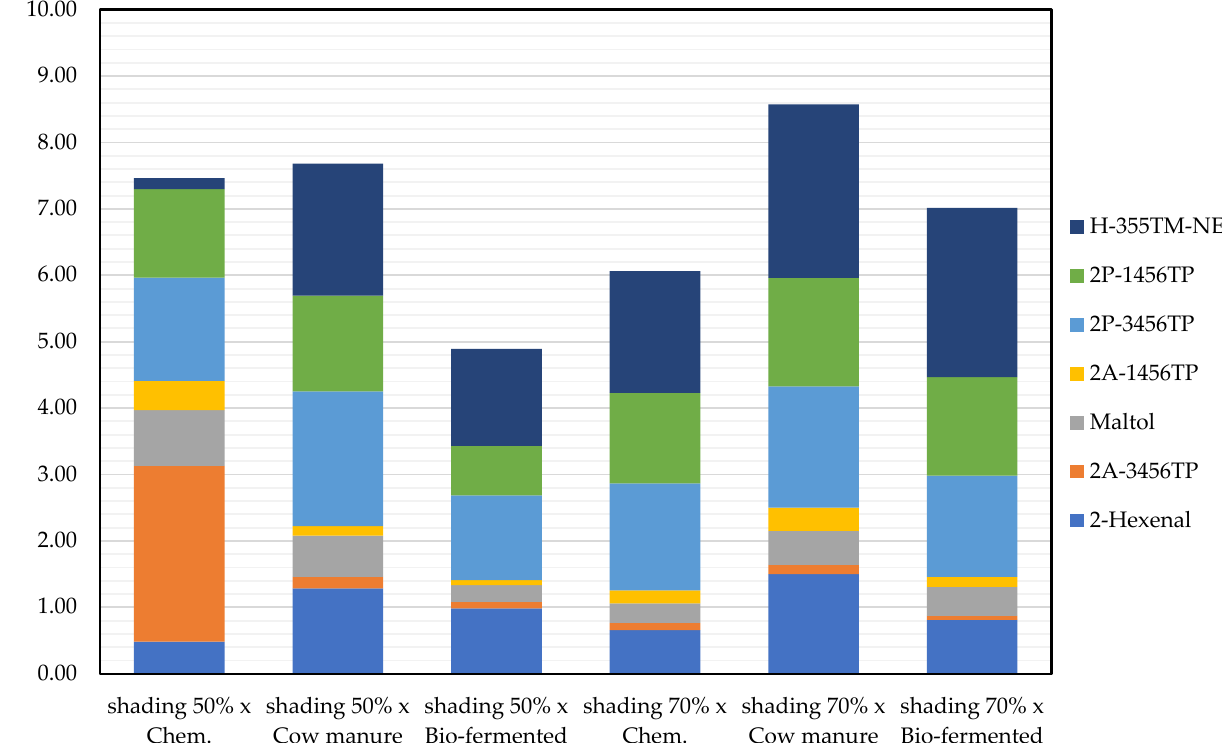
Figure 5. Potential fragrant substances found in the Niamhom leaves extracted with DCM (except 2-Hexenal from Ethyl Acetate) [Note: 2-Acetyl-3,4,5,6-tetrahydropyridine: 2A-3456TP; 2-Acetyl-1,4,5,6-tetrahydropyridine: 2A-1456TP; 2-Propionyl-3,4,5,6-tetrahydropyridine: 2P-3456TP; 2-Propionyl-1,4,5,6-tetrahydropyridine: 2P-1456TP; Hexanoic acid, 3,5,5-trimethyl-, nonyl ester: H-355TM-NE; Alpha-Hexadecanoic acid: Hexadecanoic acid; 9,12-Octadecadienoic acid (Z,Z)-: alpha-Linoleic acid].